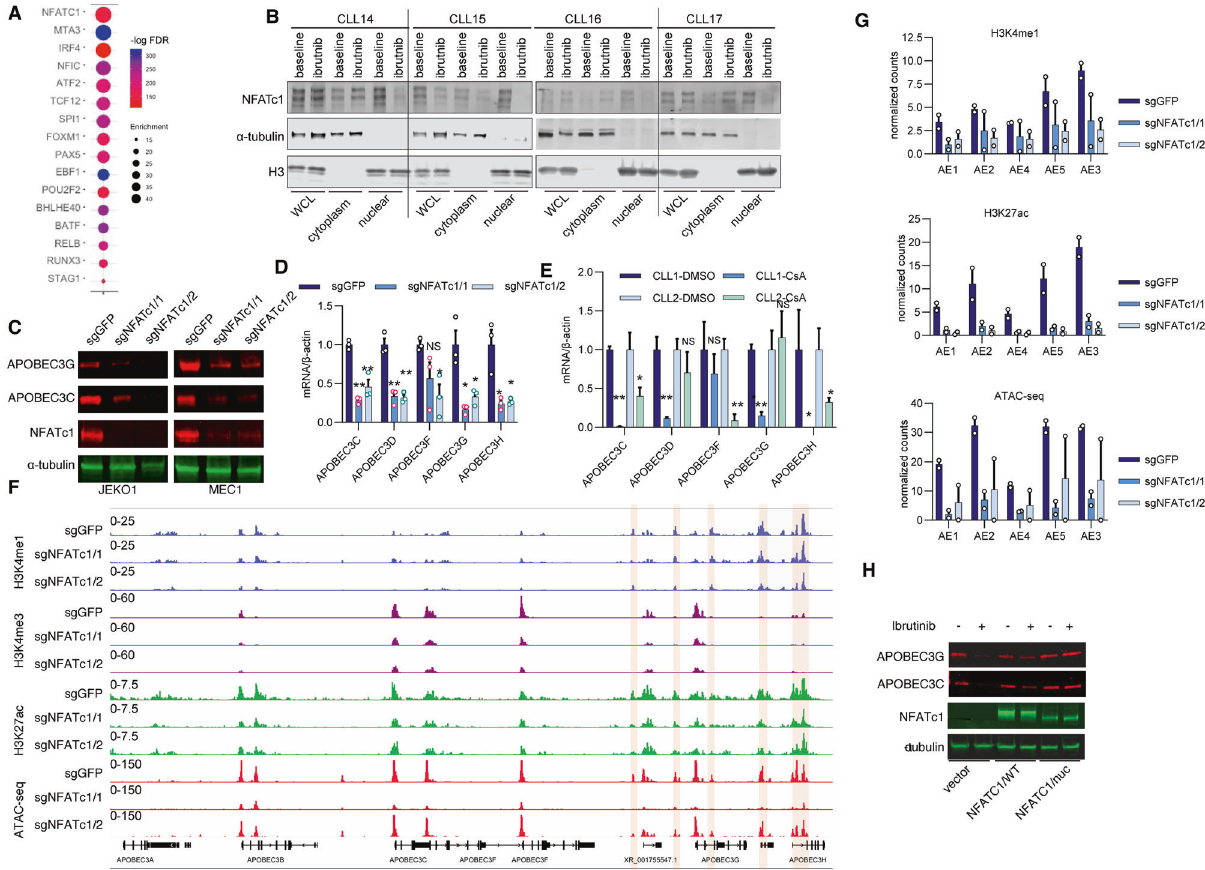
Fig. 4 NFATc1 controls the APOBEC3 expression through enhancer regulation. A Top TF motifs enriched in the regions with decreased chromatin accessibility in CLL B cells after 1-year of continuous ibrutinib treatment are shown. The differential ATAC-seq regions between ibrutinib and baseline CLL samples were analyzed by tfmotifviews [61] and randomly matched control regions were generated as control. B Western blot showing protein levels of NFATc1 in nuclear and cytoplasm fraction of CLL B cells from patients treated with or without ibrutinib. The samples were collected as in Fig. 1A. C The APOBEC3C and APOBEC3G levels were analyzed by western blot in NFATc1 depleted MEC1 and JEKO1 cells. Indicated cells were infected with sgRNAs targeting NFATc1 for 5 days and the whole-cell lysates were harvested for western blot. The intensity of each blot analysis was quanti fi ed and normalized against α -tubulin, with the normalized intensity of each blot in sgGFP control cells set to 1. D RT-qPCR analysis of APOBEC3 expression in NFATc1 depleted MEC1 cells. n = 3 independent experiments. Indicated cells were infected with sgRNAs targeting NFATc1 for 5 days before the RNA was puri fi ed and analyzed by RT-PCR. E RT-qPCR analysis of APOBEC3 expression in CLL B cells treated with 2.5 μ M Cyclosporin A for 24 h. F Genome tracks showing CUT&Tag of H3K4me1, H3K4me3, H3K27ac, and ATAC-seq pro fi les of APOBEC3 genes in NFATc1 depleted and control MEC1 cells. The cells were treated as in panel ( D ). G Normalized read counts of the CUT&Tag and ATAC-seq results in panel ( F ), n = 2 independent experiments for each histone mark. H Western blot showing protein levels as indicated in wildtype (NFATc1/wt) or nuclear stable form (NFATc1/nuc) NFATc1 expressing MEC1 cells treated with or without ibrutinib at 2.5 µM for 3 days. NFAT1c1 was detected by Flag